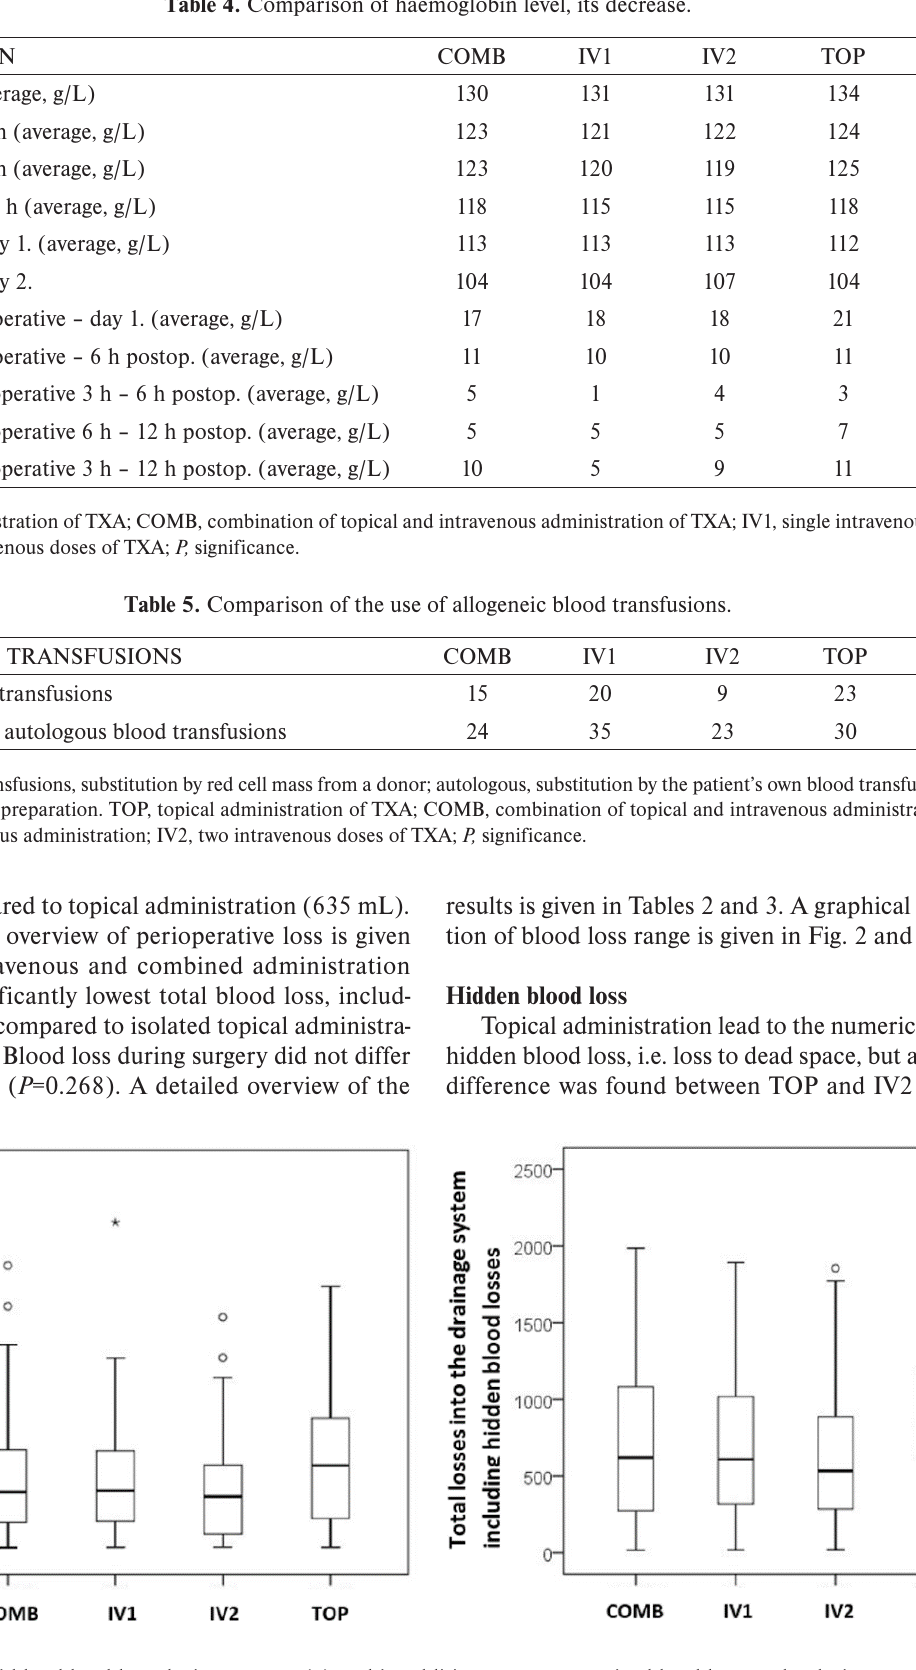
Fig. 4. Range of hidden blood loss during surgery (a) and in addition to postoperative blood loss to the drainage system (b) for each